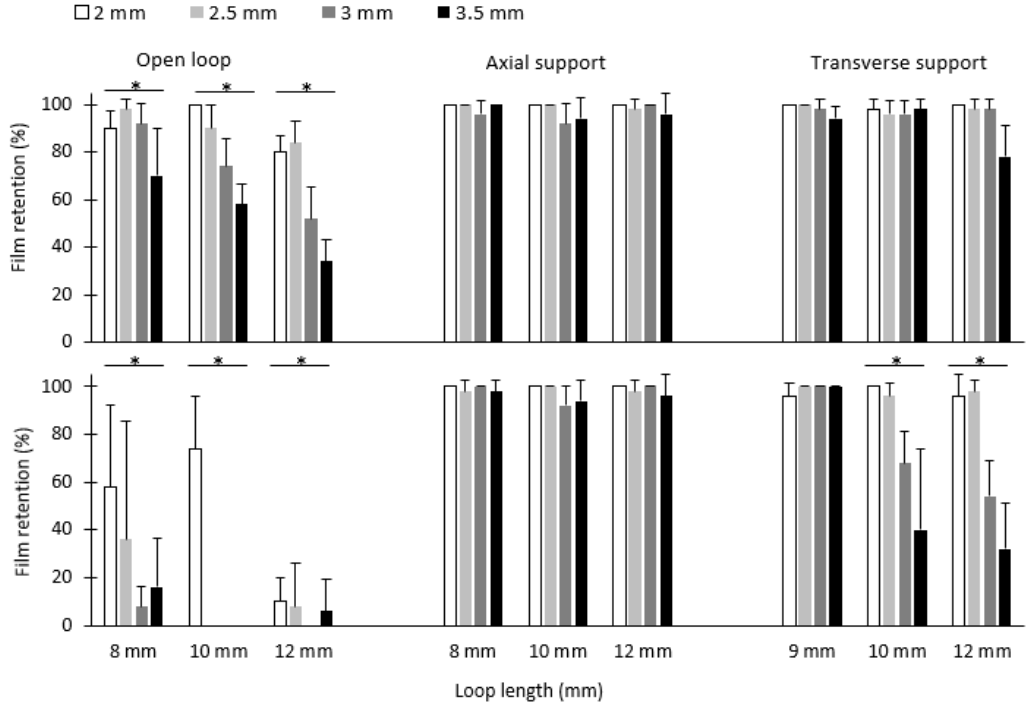
Figure 4. Film retention of water samples prior to exposure to liquid nitrogen. The VCVD was positioned horizontally ( upper ) and vertically ( bottom ) for different support configurations, loop lengths, and loop widths. Error bars represent the standard deviation. Asterisks indicate significant differences among different loop lengths.